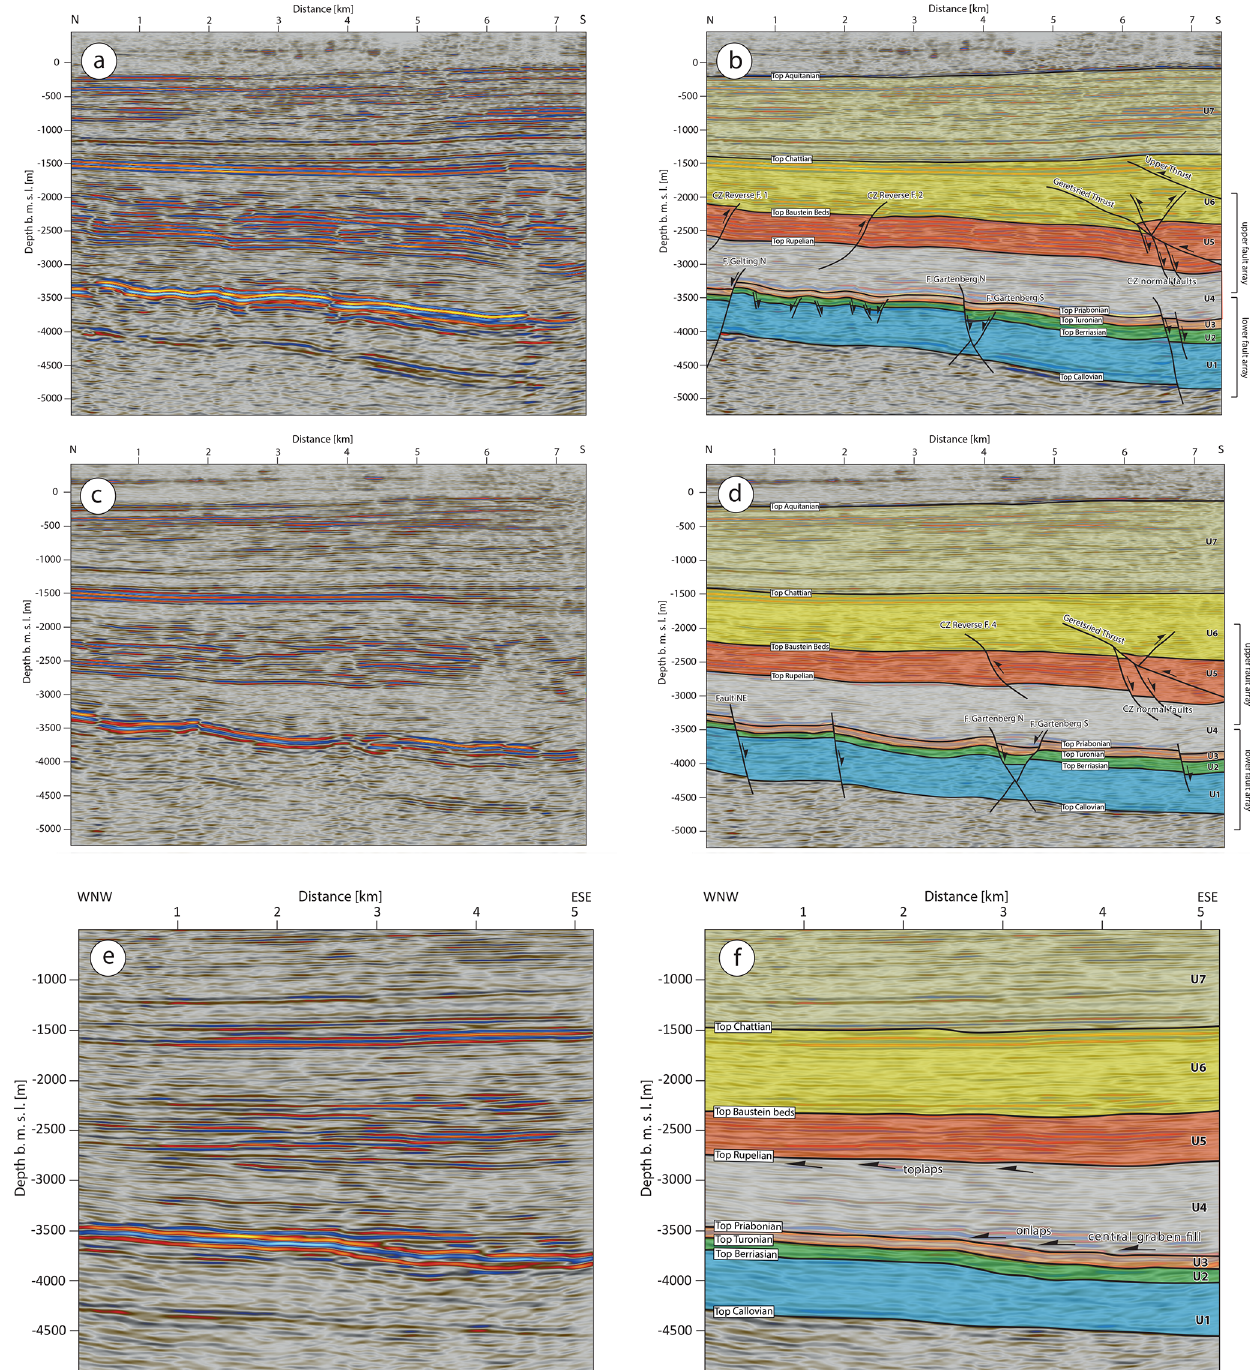
Figure 3. (a) N–S-oriented seismic section across the centre of the 3-D survey, where panel (b) shows interpreted seismic-stratigraphic units and faults. (c, d) N–S-oriented seismic section across the eastern margin of the 3-D survey. The faults we refer to in this work are named. (e, f) WNW–ESE-oriented seismic section through the central graben, along its strike. It shows thinning of Unit 1 (carbonate platform), onlapping and toplapping of reflections within Unit 4. See Fig. 6 for location of the